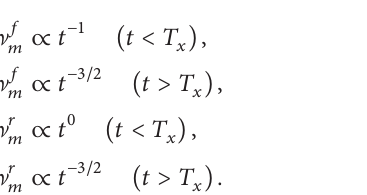
lightcurves could be distributed into different morphological types; we will discuss this in detail in Section